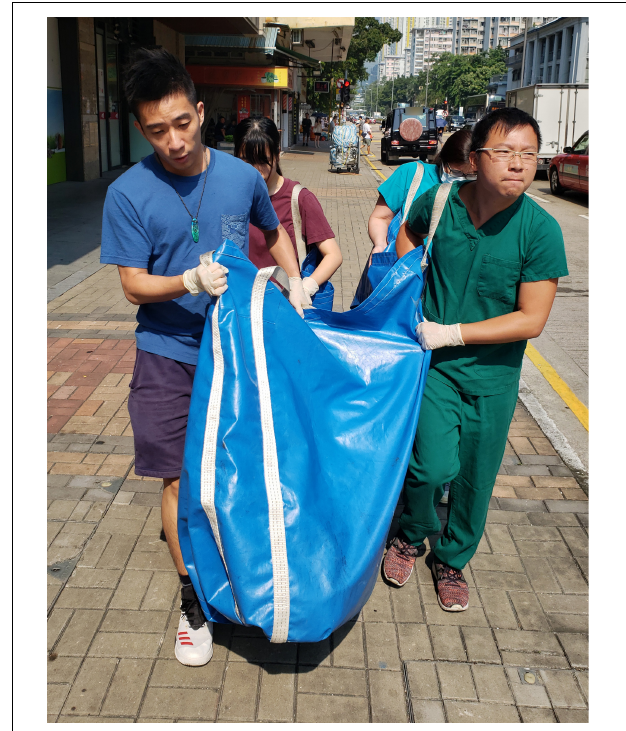
FIGURE 5 | Tailor-made equipment, a portable radiolucent stretcher with retractable handles, was designed by OPCFHK for carrying the carcasses.